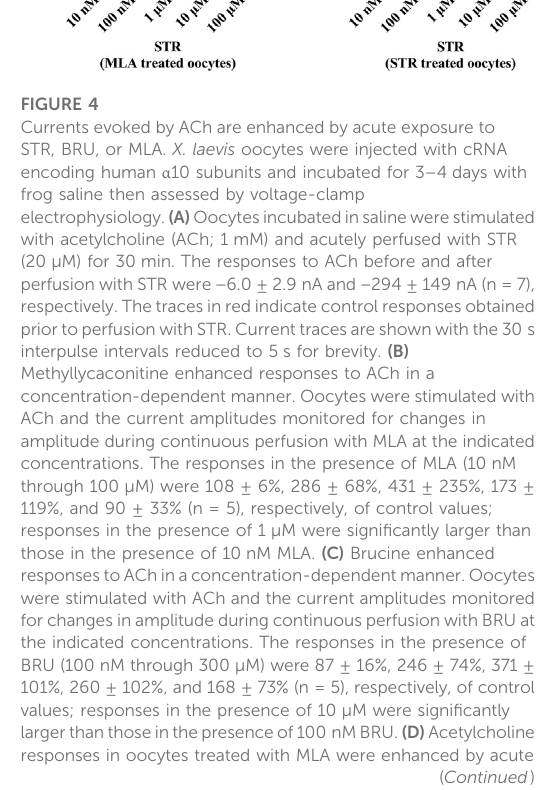
α 10 nAChRs including α 9 homomers and α 9 α 10 heteromers. Acute STR (20 μ M) perfusion of oocytes expressing α 9 homomers almost completely inhibited ACh-evoked responses (Figure 5A). By contrast, those from oocytes expressing α 10 nAChRs were inhibited by only ~50% at the same concentration (Figure 5B). Acute perfusion with STR inhibited the ACh-evoked responses in oocytes (incubated in saline) expressing α 9 and α 10 subunits by ~99% (Figure 5C).